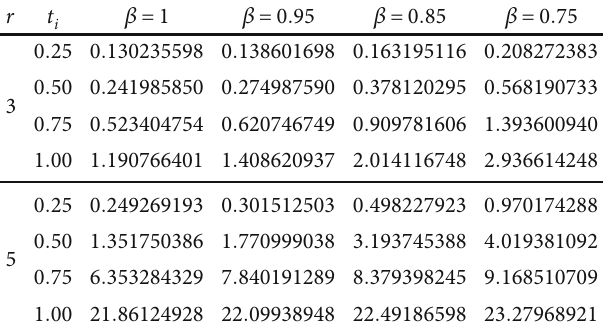
Table 4: Numerical results of the approximated solution at n = 5 and L = 7 with di ff erent values of β and r for Example